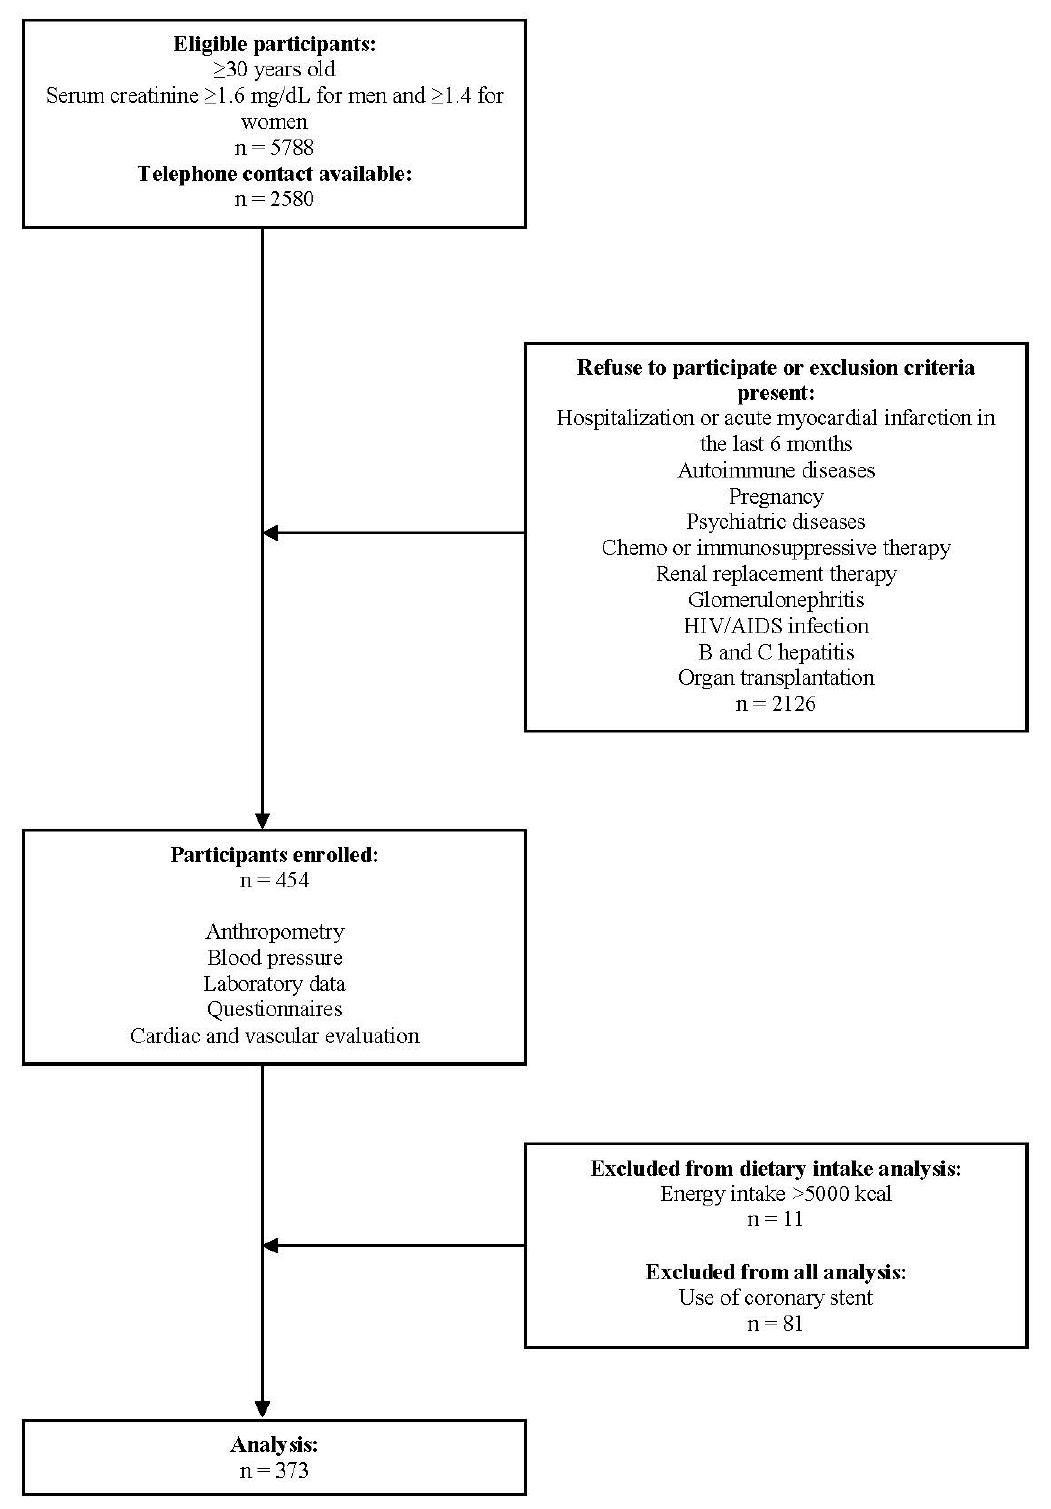
Figure A1. Participant flow chart.